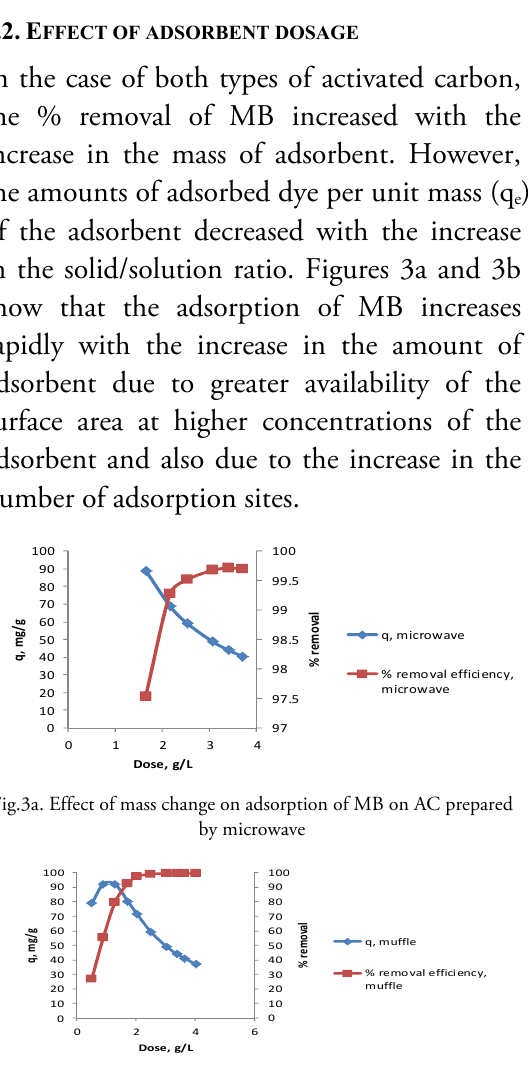
Fig.3b. Effect of mass change on adsorption of MB on AC prepared